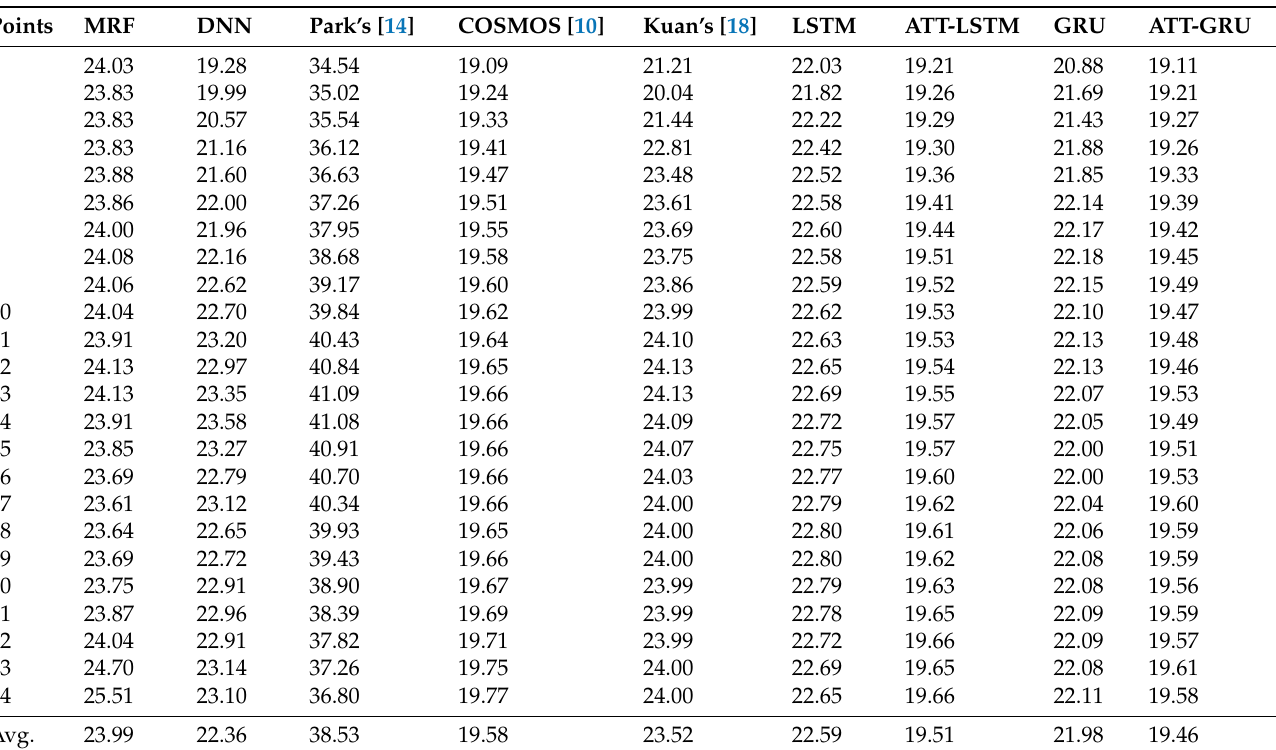
Table A5. Coefficient of variation of the root mean squared error comparison for Building 2.